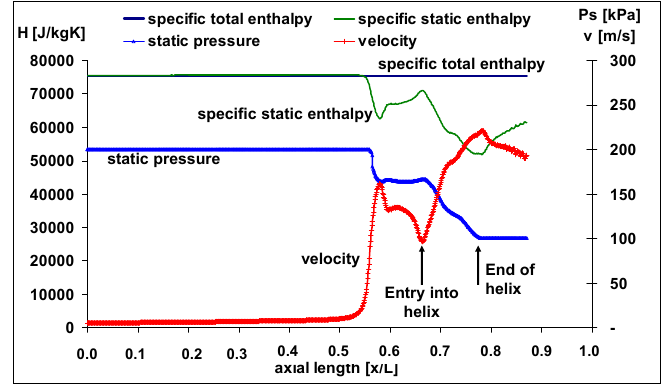
Figure 7. Enthalpies, static pressure and velocity variation in the windback seal as a function of the axial length.